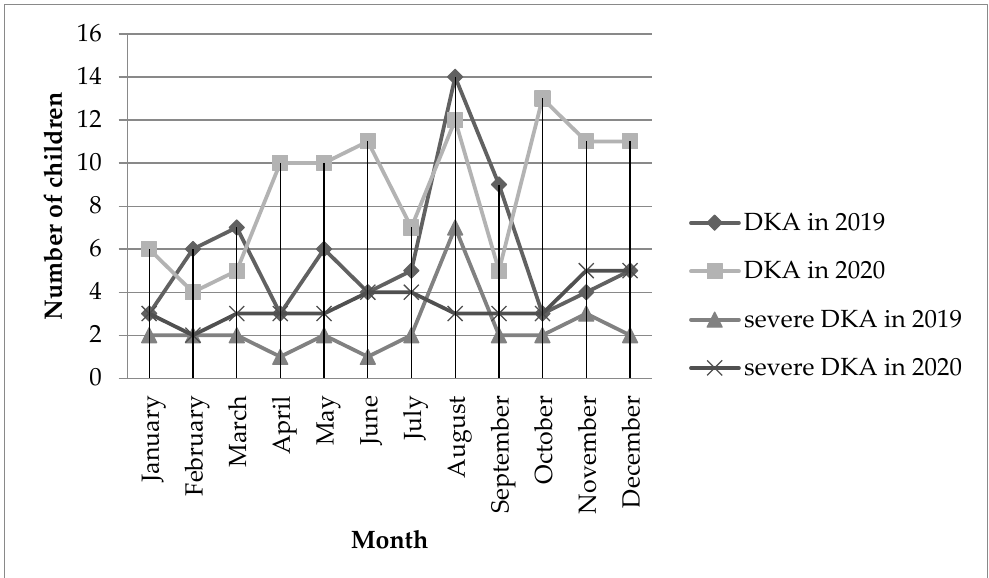
Figure 3. The number of DKA and severe DKA in children in 2019 and 2020 by month.